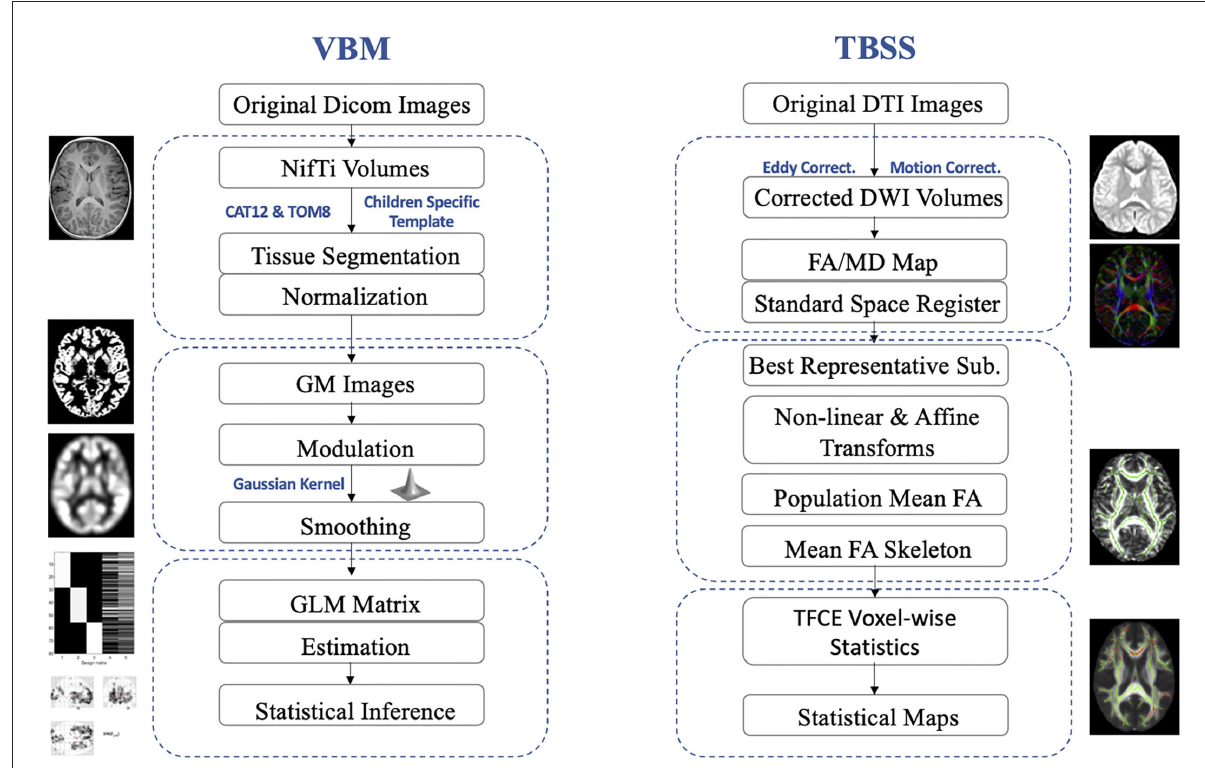
FIGURE1 Pediatric-adjusted pipelines for VBM and TBSS. VBM, voxel-based morphometry; TBSS, tract-based spatial statistics; GM, gray matter; DTI, diffusion tensor imaging; DWI, diffusion-weighted image; FA, fractional anisotropy; MD, mean diffusivity; GLM, general linear model; TFCE, threshold-free cluster